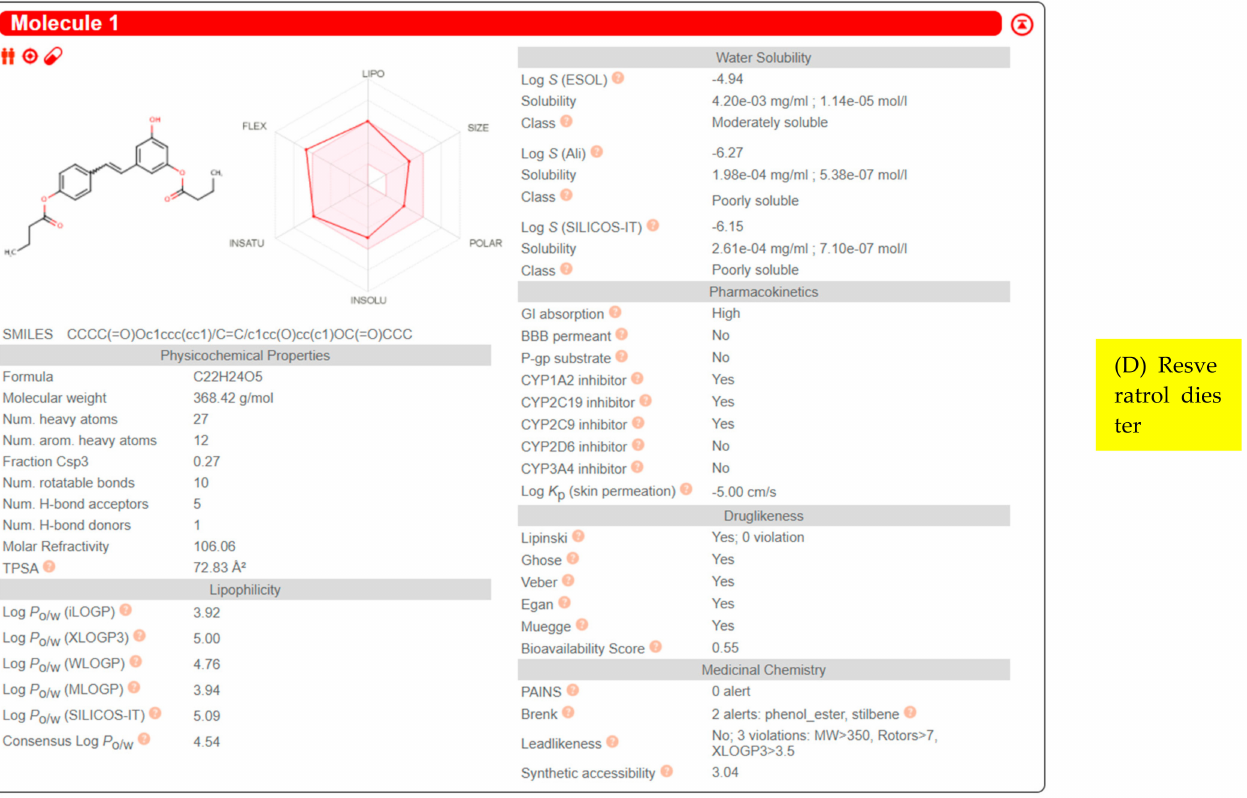
Figure A2. The SwissADME evaluation of ( A ) resveratrol, ( B ) resveratrol mono-ester (1), ( C ) resveratrol mono-ester (2), and ( D ) resveratrol diester (data source: the free SwissADME software http://www.swissadme.ch/index.php, accessed on 20 April